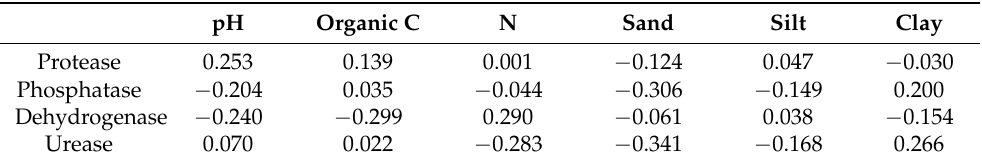
Table 3. Correlations between enzyme activities and characteristics of studied soils [33];